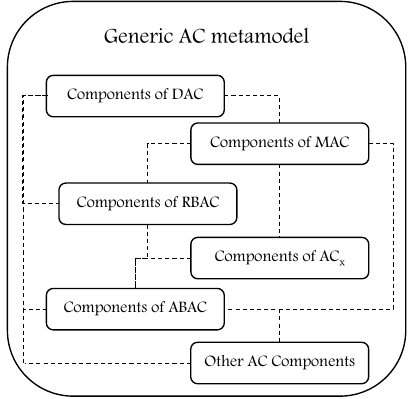
Figure 6. The concept of generic AC metamodel.